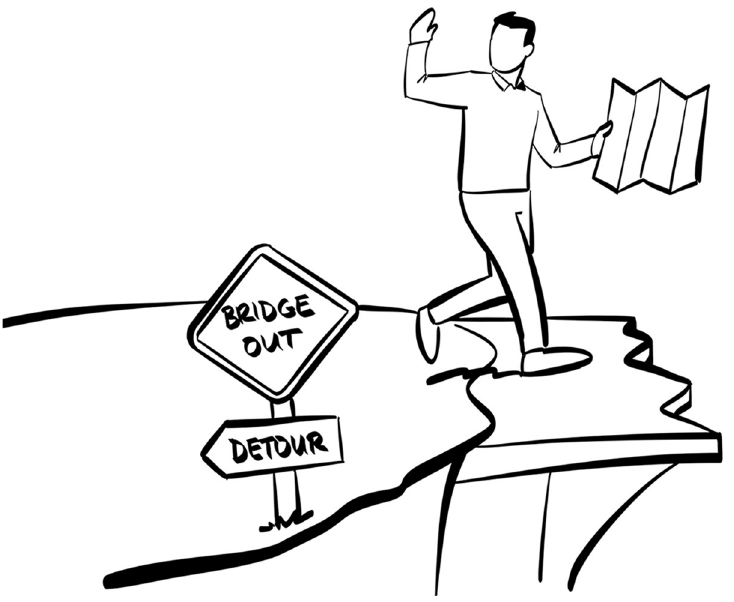
Fig 6. Never rethink the